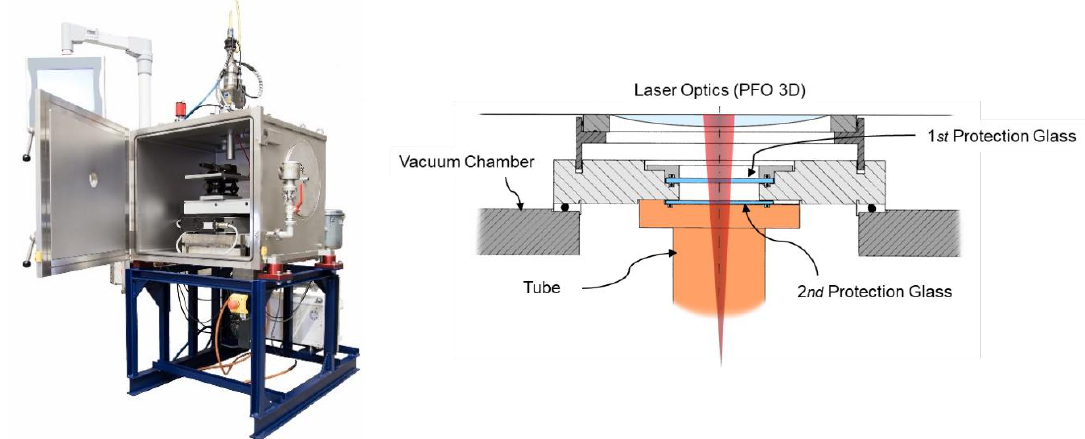
Figure 2. Experimental setup for laser welding at reduced ambient pressure ( left ) and schematic beam guidance ( right ).